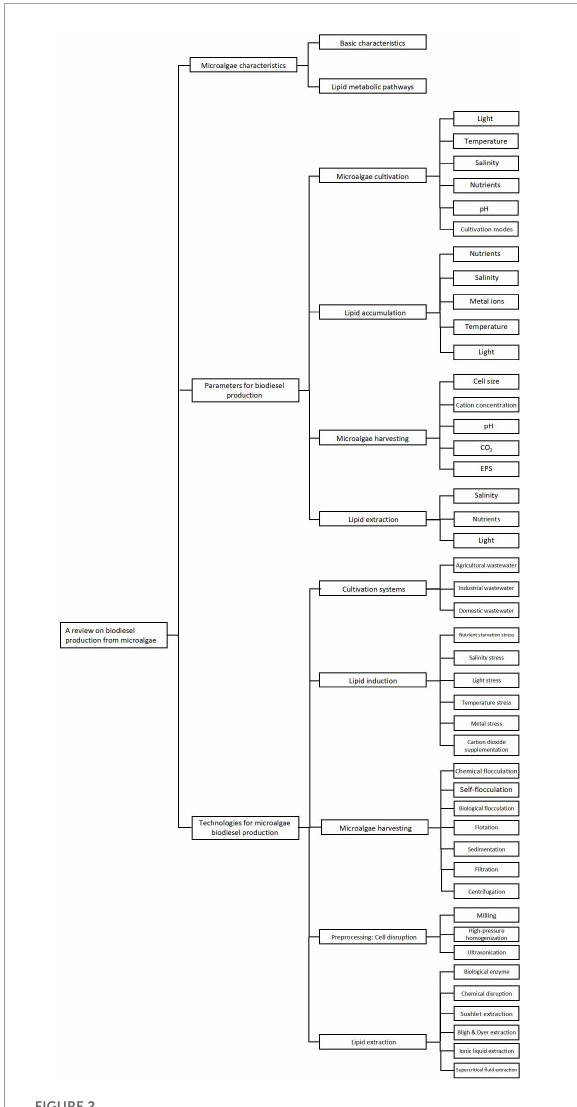
FIGURE2 Schematic diagram of main content in this